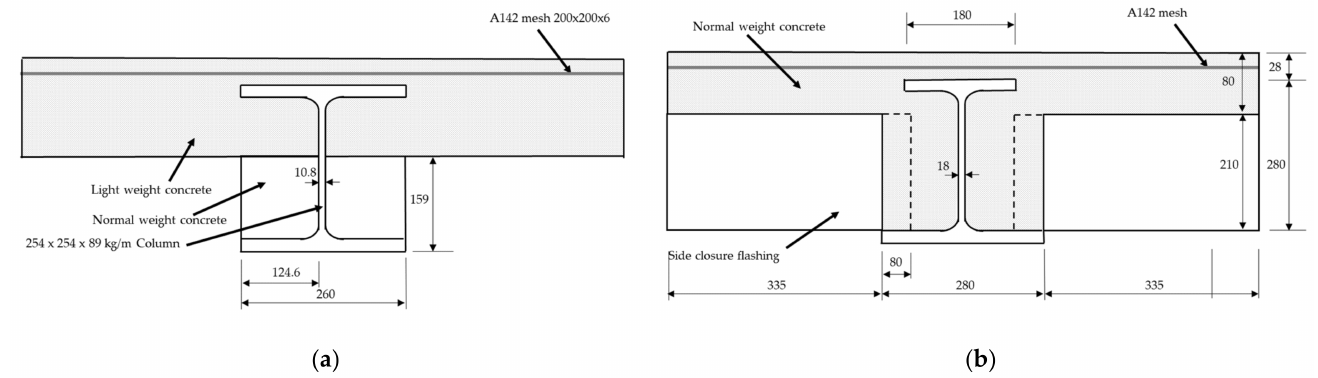
Figure 4. Cross-section of the experimental test configuration: ( a ) WRFC 44174 [23]; ( b ) WFRC 66162